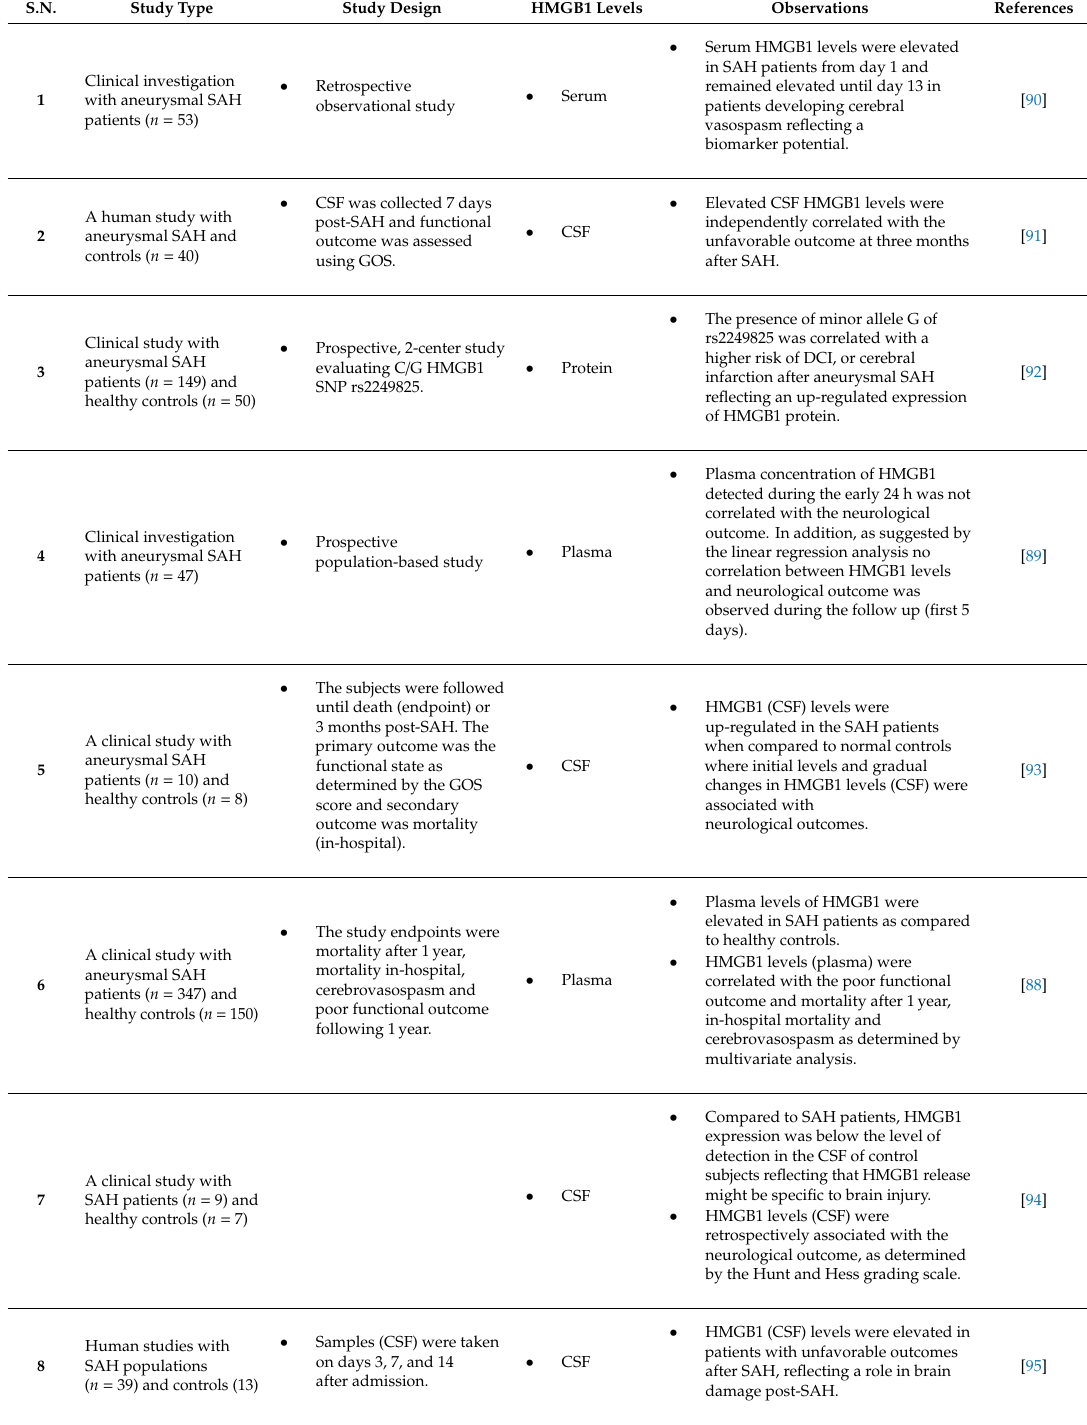
Table 2. Studies indicating the biomarker potential of HMGB1 after